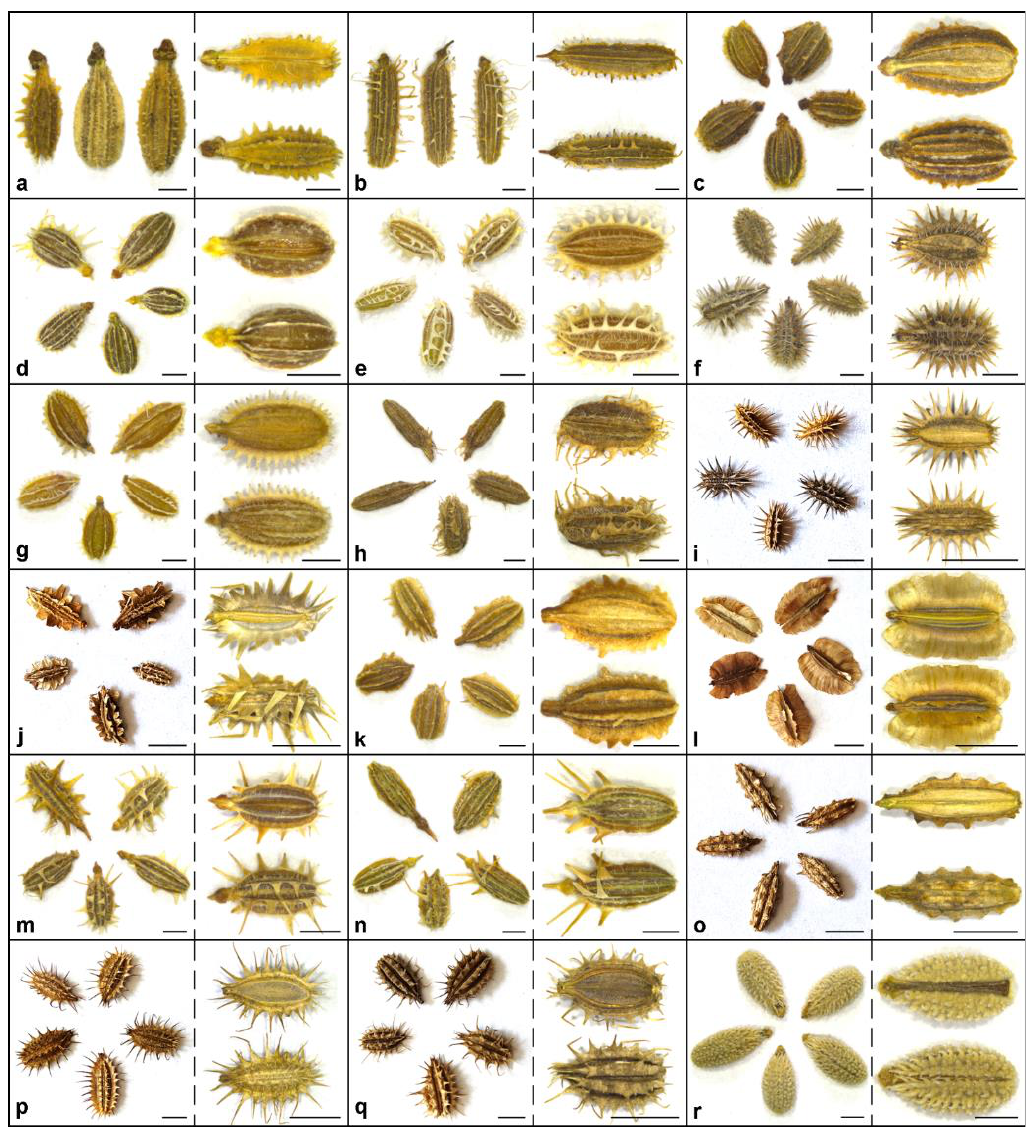
Figure 2. Variation in fruit morphology of the investigated Daucus and closely related non- Daucus taxa. The insets show magnified views of the dorsal (lower) and ventral (upper) sides of the mericarps. ( a ) D . aureus ; ( b ) D . carota subsp. capillifolius ; ( c ) subsp. sativus (DH); ( d ) subsp. sativus (‘Dolanka’); ( e ) D . conchitae ; ( f ) D . glochidiatus ; ( g ) D . guttatus ; ( h ) D . involucratus ; ( i ) D . littoralis ; ( j ) D . muricatus ; ( k ) D . pusillus ; ( l ) D . rouyi ; ( m ) D . sahariensis ; ( n ) D . syrticus ; ( o ) Caucalis platycarpos ; ( p ) Orlaya daucoides ; ( q ) O . daucorlaya ; ( r ) Torilis arvensis . Scale bars: 1 mm ( a – h , k , m , n , r ); 5 mm ( i , j , l , o – q ).